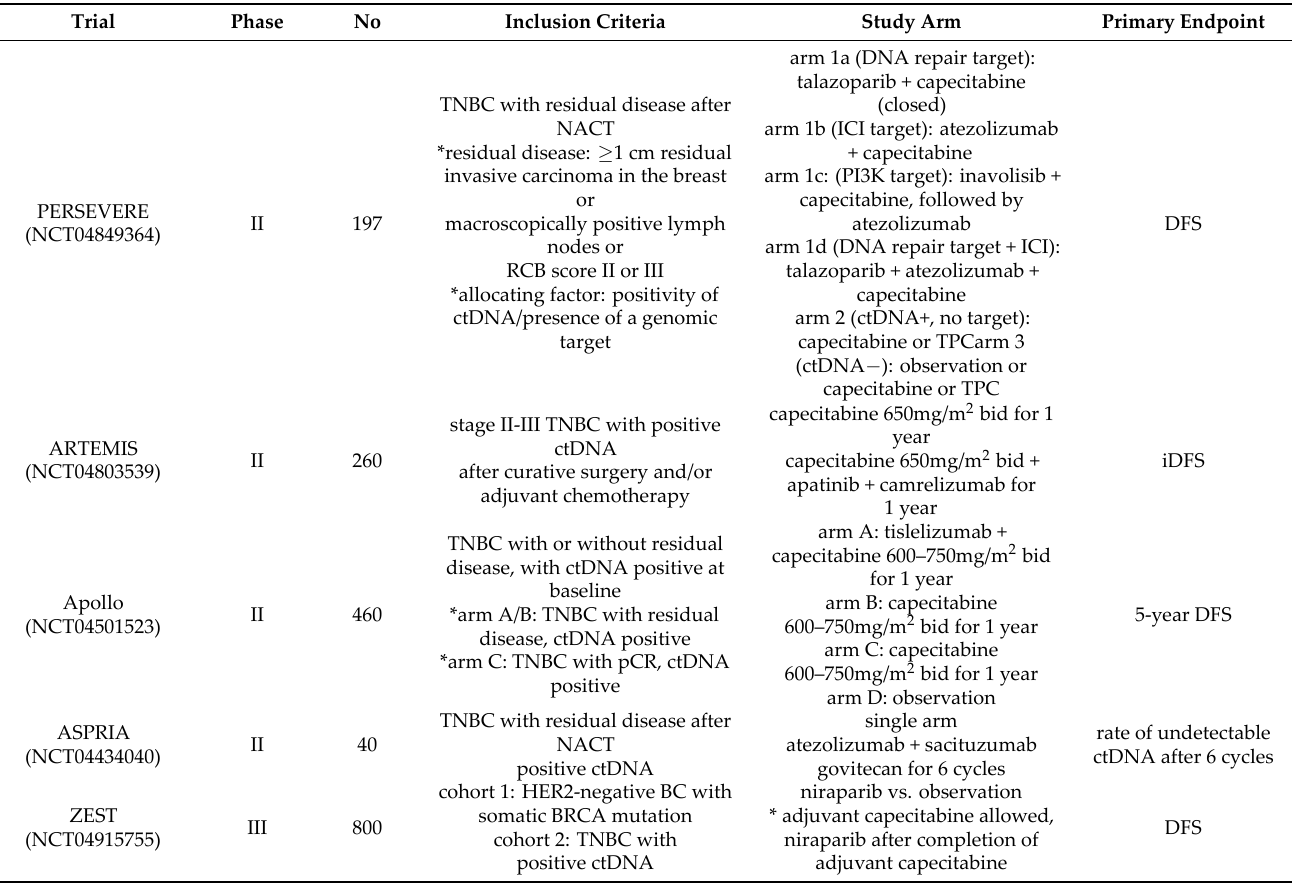
Table 3. Summary of ongoing trials according to